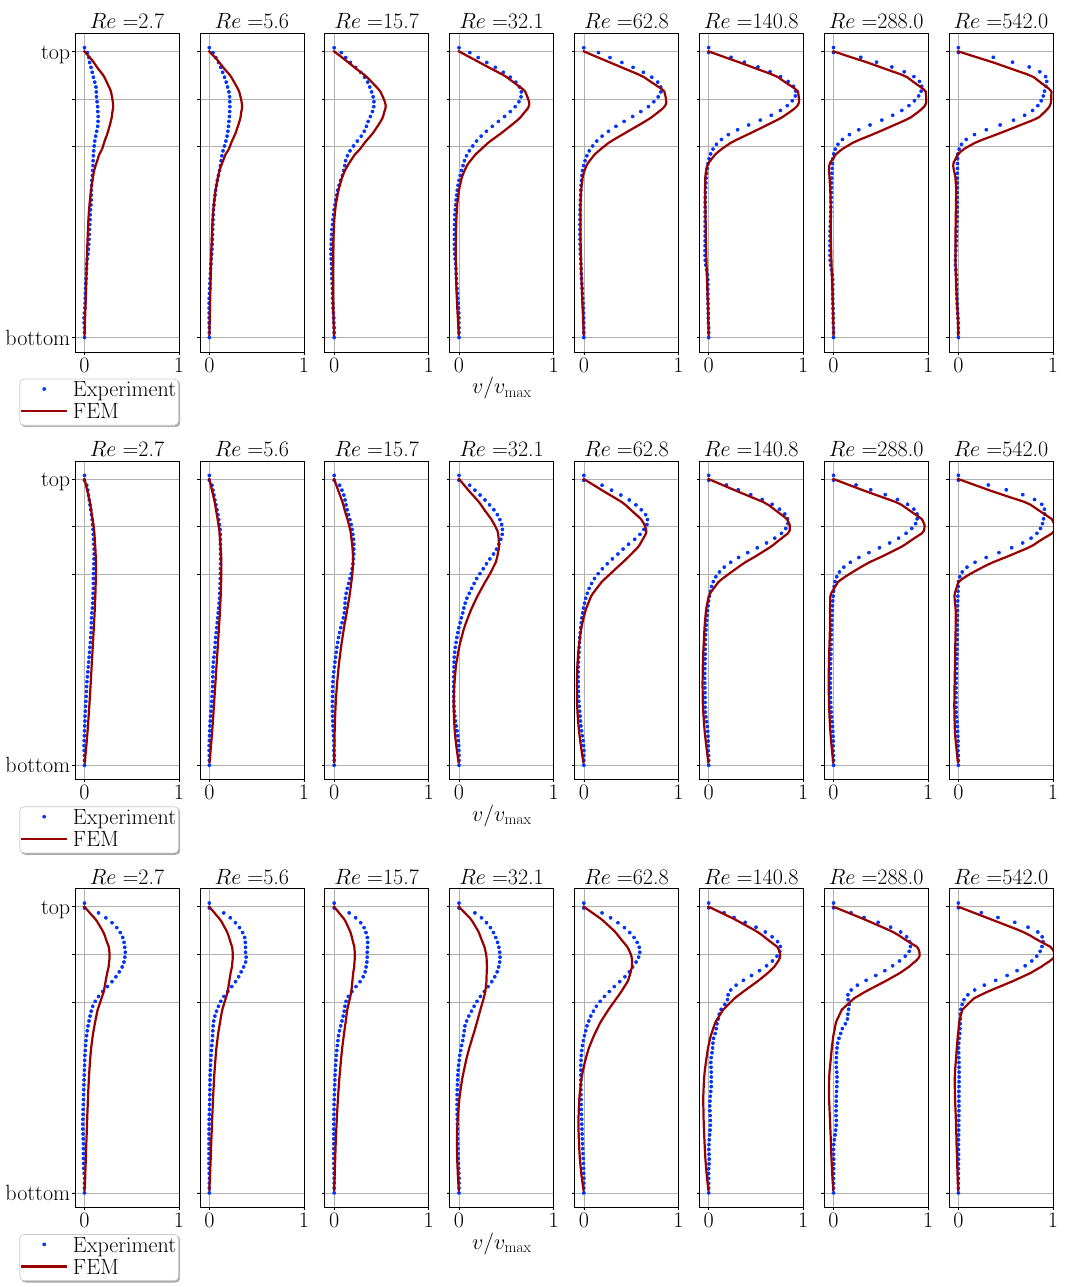
ity profiles are normalized by v max for corresponding R eynolds num- bers, Re, of cases (a)–(h) given in Table